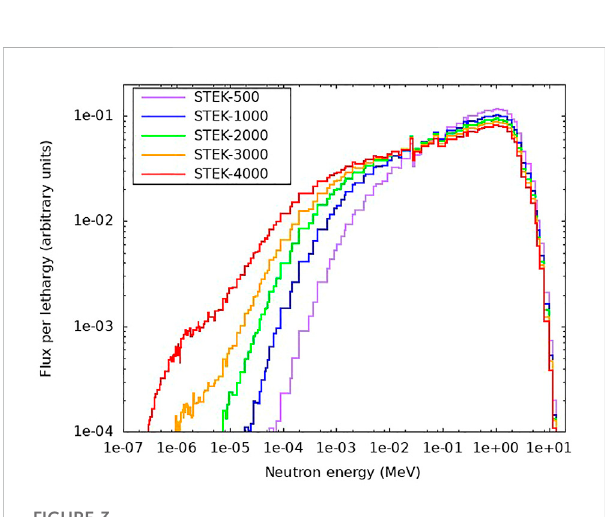
FIGURE 3 The neutron spectrum in the sample position in the fi ve core con fi gurations of